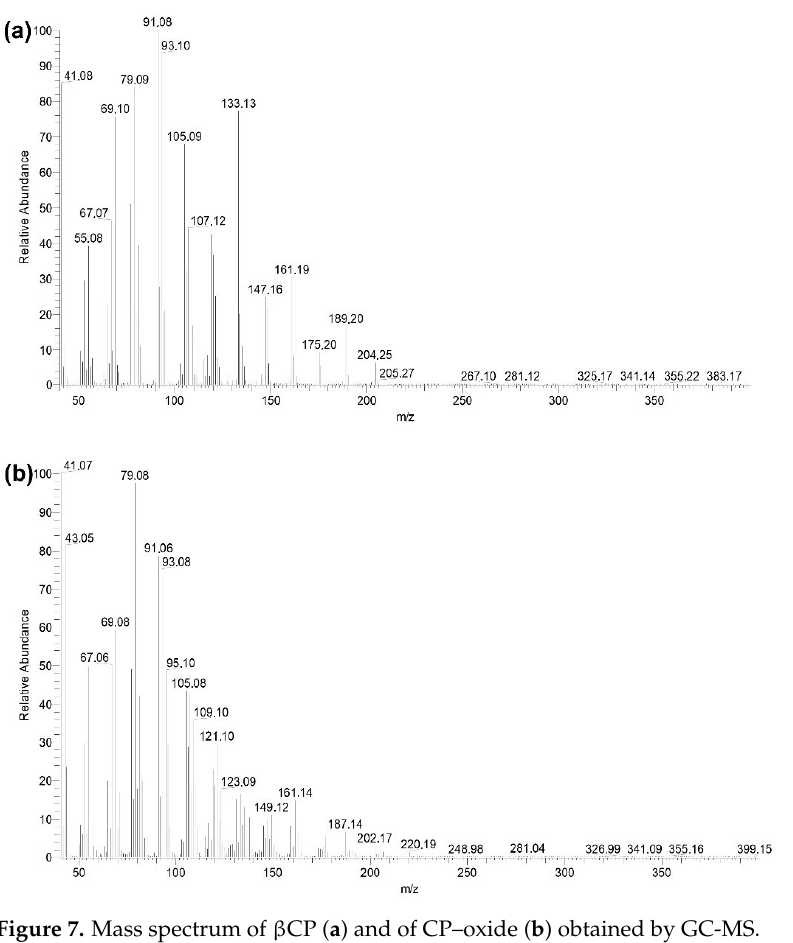
Figure 7. Mass spectrum of β CP ( a ) and of CP–oxide ( b ) obtained by GC-MS.